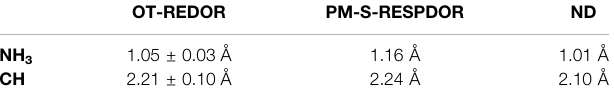
H (blacksquares)at τ 0 ofN mix